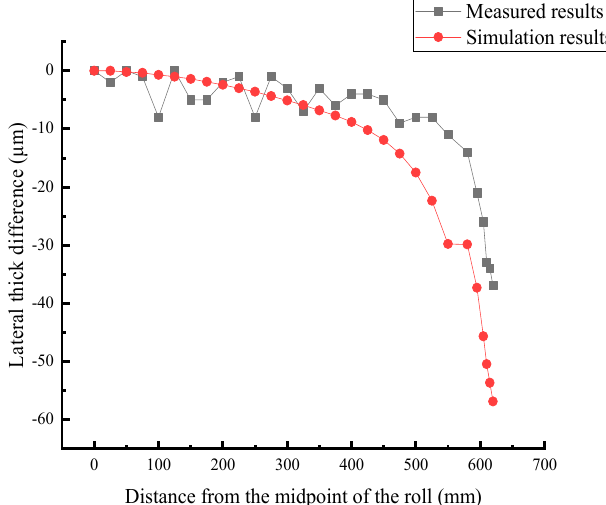
Figure 5. The comparison between the simulation results and the measured results.